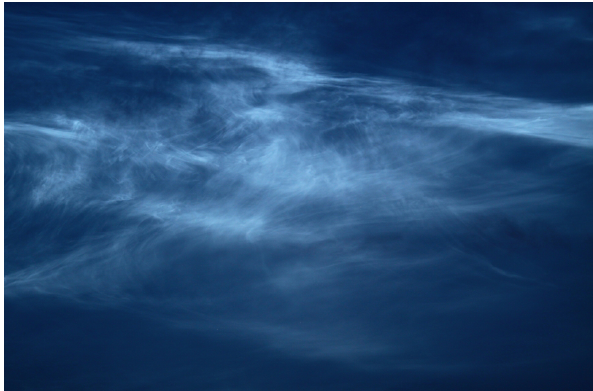
Figure 1. Photograph of NLCs taken by Gerd Baumgarten on 14 July 2009 from Djurhamn,